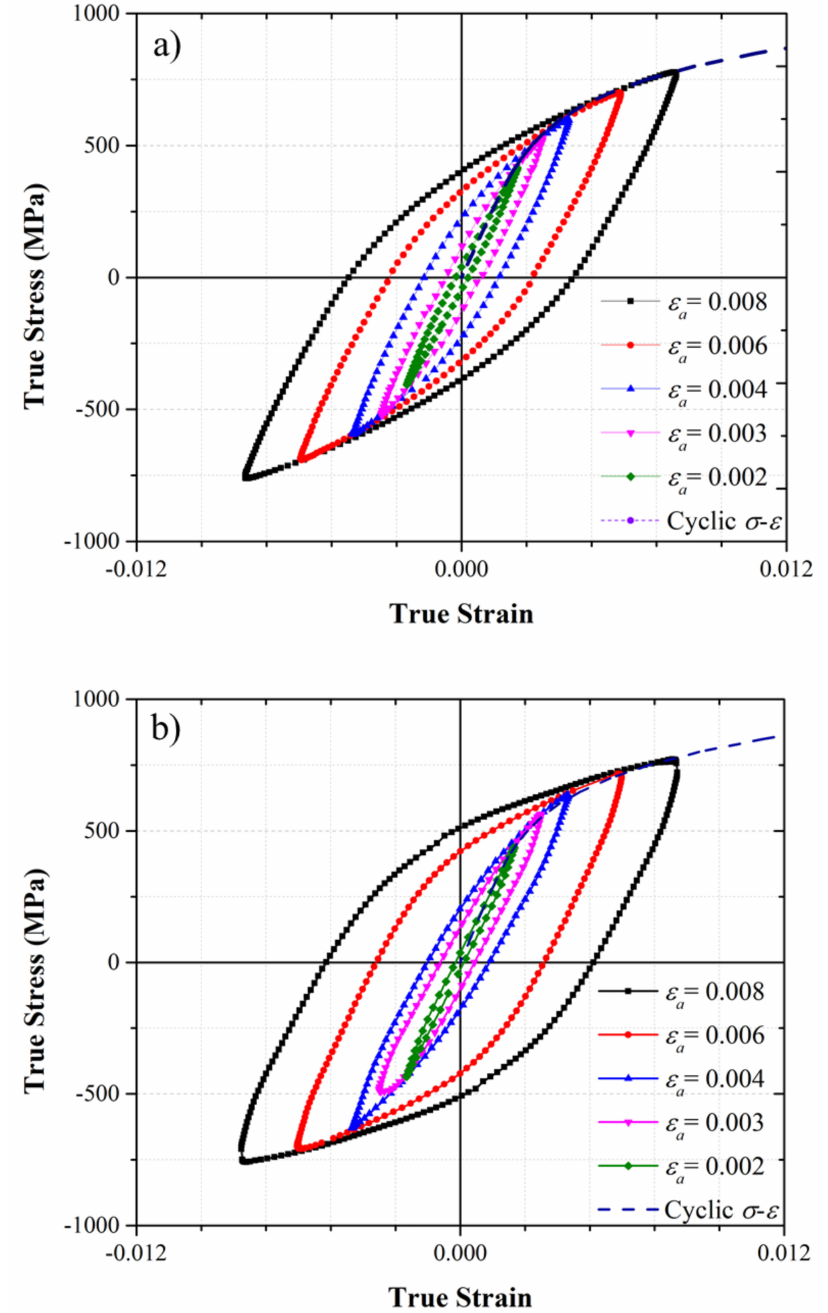
Figure 10. Hysteresis loops in LCF corresponding to ( a ) DP980 steel sheet and ( b ) welded